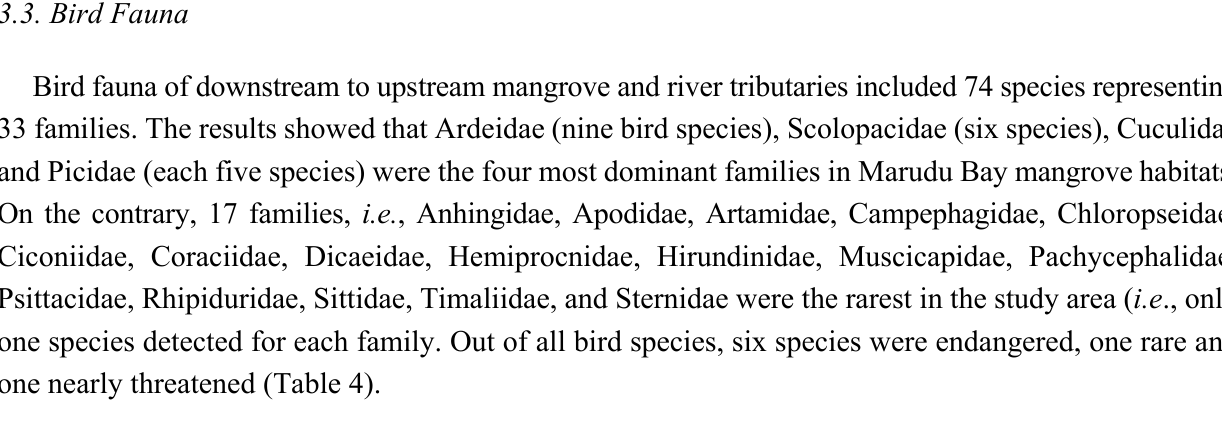
Table 4. List of bird species detected in Marudu Bay Mangrove